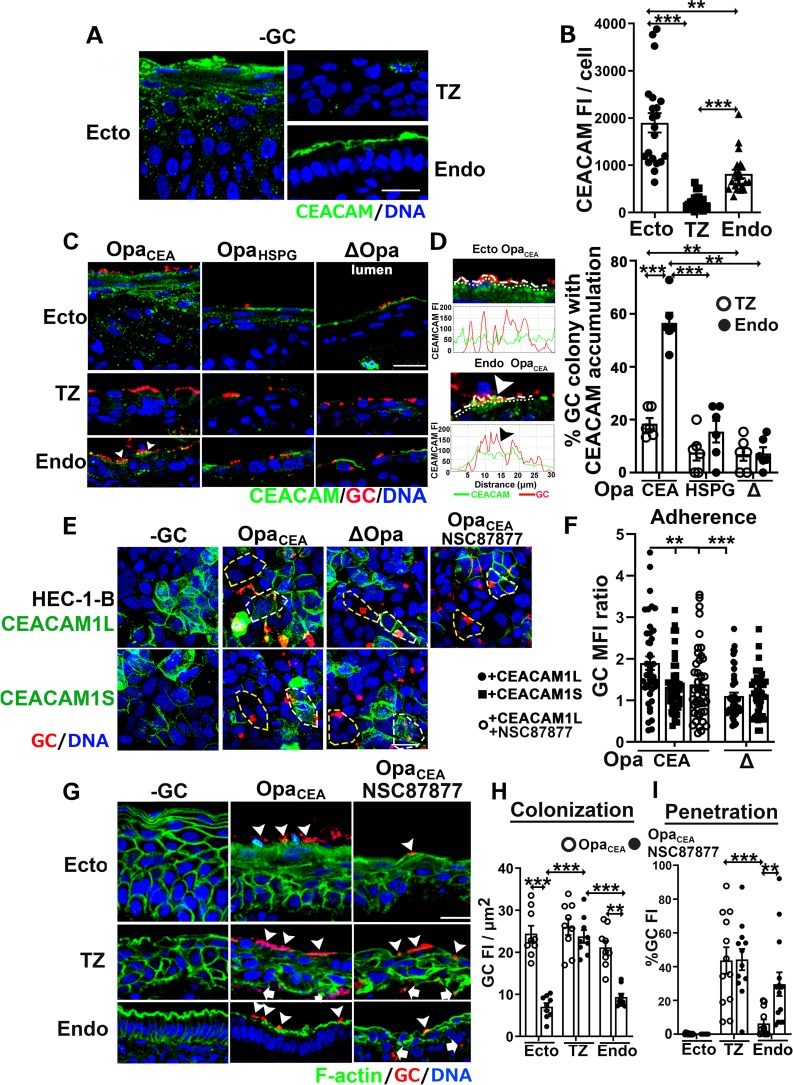
Heterogeneous expression levels of CEACAMs on cervical epithelial cells regulate GC infectivity.(A) Shown are representative CFM images of uninfected human cervical tissue explants stained with anti-CEACAM antibody (reacting with CEACAM 1, 3, and 6). See also S3 Video. (B) The levels of CEACAM expression were measured by the mean (±SEM) of CEACAM FI per cell, generated from 21 images per cervical region acquired from 2~4 independent analyses of 3 human cervixes. (C-D) Tissue explants were inoculated with piliated OpaCEA, OpaHSPG, and ΔOpa GC for 24 h (MOI~10), washed at 6 and 12 h post-inoculation and cryopreserved. Tissue sections were collected, processed, stained for GC and CEACAMs, and analyzed using CFM. Shown are representative CFM images (C). Arrowhead, GC microcolonies colocalize with CEACAM staining accumulated underneath. The spatial relationship of GC with CEACAMs was quantified by the percentage of GC microcolonies with CEACAM staining accumulation underneath or nearby using FI line profiles of GC and CEACAMs (D). Shown are the means from 2 independent analyses of cervical tissues from 3 human subjects. (E-F) HEC-1-B cells were transiently transfected with or without CEACAM1L or 1S and infected with Pil+OpaCEA or Pil+ΔOpa GC (MOI~10) for 6 h in the absence or presence of the SHP1/2 inhibitor, NSC878777 (20 μM). Shown are representative CFM images (E). White dashed lines circle CEACAM-expressing cells. Yellow dashed lines circle cells that do not express CEACAMs. The levels of GC adherence to CEACAM1L or 1S-expressing cells were compared to those that did not express CEACAMs by the MFI ratio (±SEM) of GC on CEACAM-positive cells versus CEACAM-negative cells in the same images (F). Shown were the mean of 45 CEACAM1-positive regions and the corresponding CEACAM1-negative regions in 15 images acquired in 3 independent experiments. (G-I) Cervical tissue explants were inoculated with Pil+OpaCEA GC in the presence or absence of the SHP inhibitor NSC87877 (20 μM) for 24 h, and tissue sections were stained for GC, F-actin, and DNA. Shown are representative CFM images (G). Arrowheads, colonizing GC, and arrows, penetrating GC. The levels of GC colonization at the ectocervix, TZ and endocervix were quantified by GC FI per μm2 (±SEM) of the luminal surface (H), and the levels of GC penetration into the subepithelia of the ectocervix, TZ and endocervix were measured as the percentage (±SEM) of GC FI at the subepithelium (I). Shown are the means from cervical tissues of 3 human subjects as described in Fig 1. Scale bar, 20 μm. **p< 0.01; ***p<0.001, as determined by Student’s t-test and one-way non-parametric ANOVA (Kruskal-Wallis test).